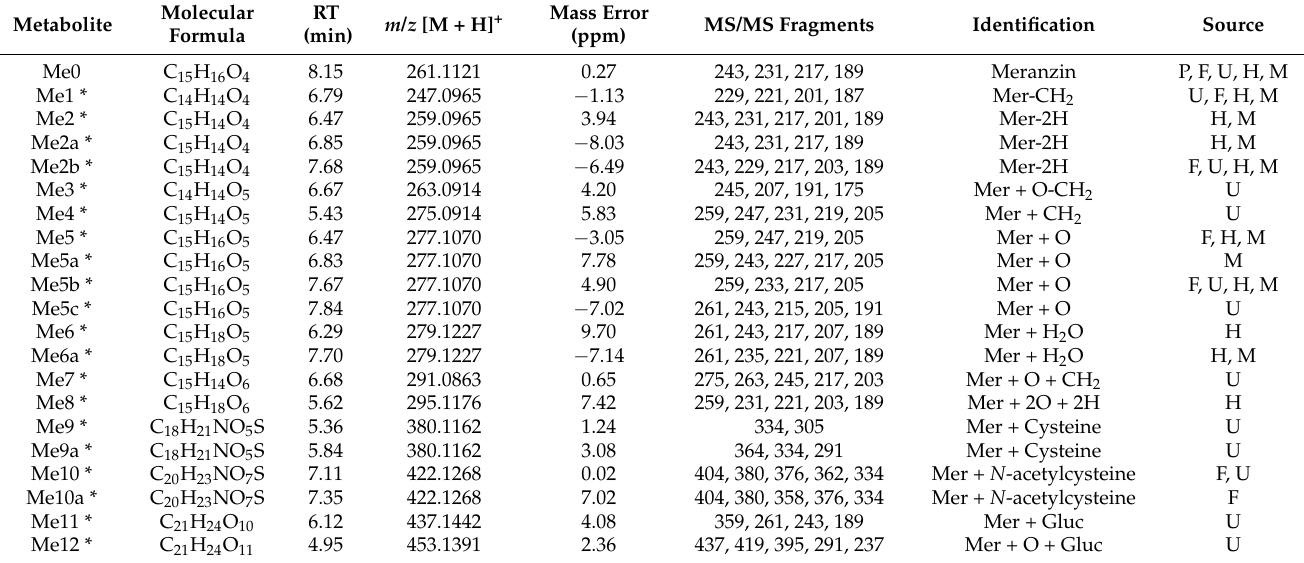
Table 1. Summary of MER metabolites produced in vivo and in vitro